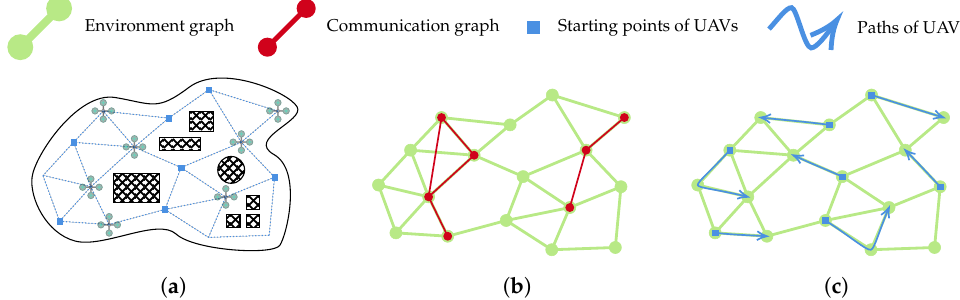
Figure 2. Swarm of UAVs covering an area with obstacles. The UAVs are flying from different bases (blue squares) following the discretisation of the map (dashed blue lines), as shown in ( a ). At that time, the environment graph (in green) and the communication graph (in red) are represented in ( b ). The current solution as a set of paths (in blue) is depicted in ( c